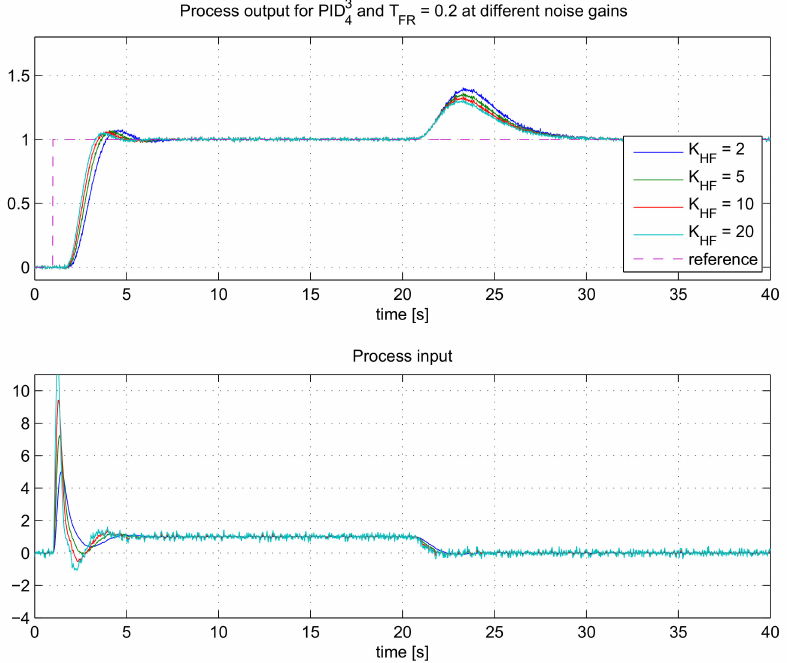
Figure 7. The closed-loop responses for the process G P 3 ( s ) when using controllers PID 3 ent K HF